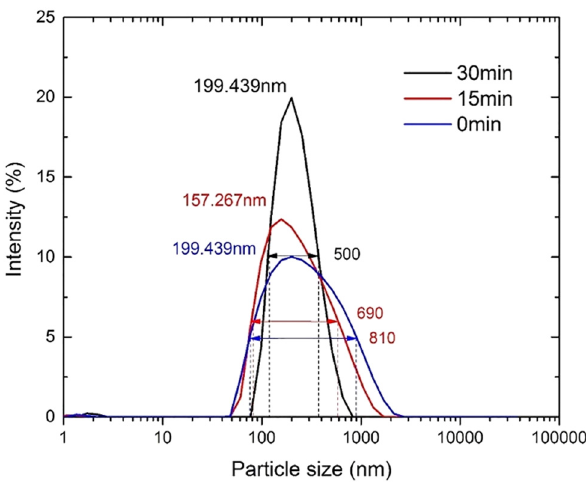
Figure 4: Size distributions of GO particles under di ff erent disper - sing processes [ 46 ]